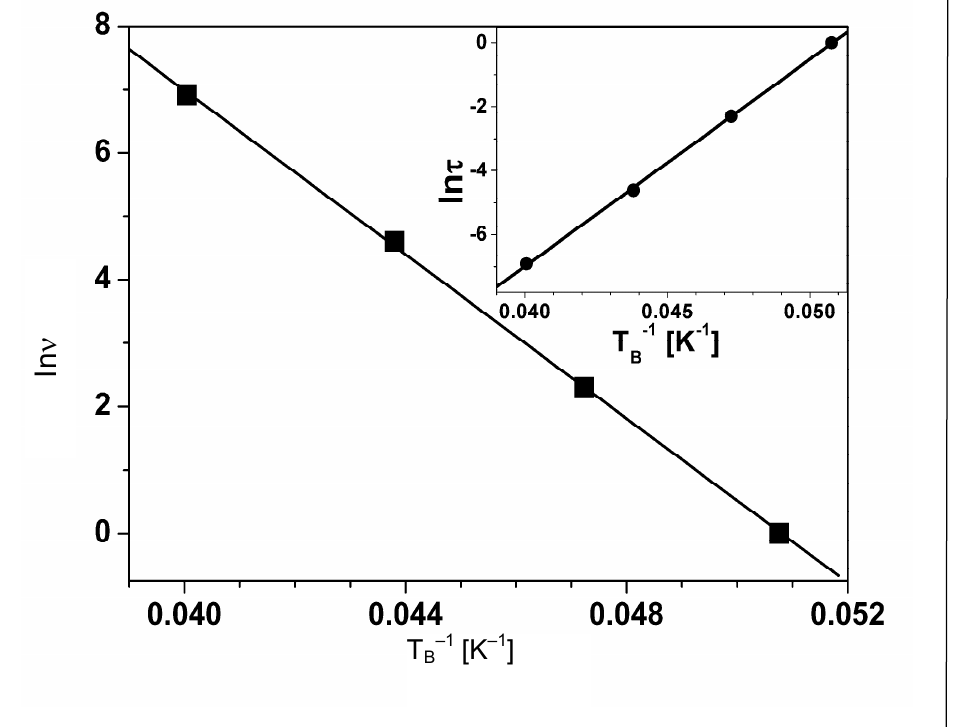
Figure 10 – Change of blocking temperatures TB with AC field frequency ν fitted to the Arrhenius function. Inset: fit to the Vogel-Fulcher